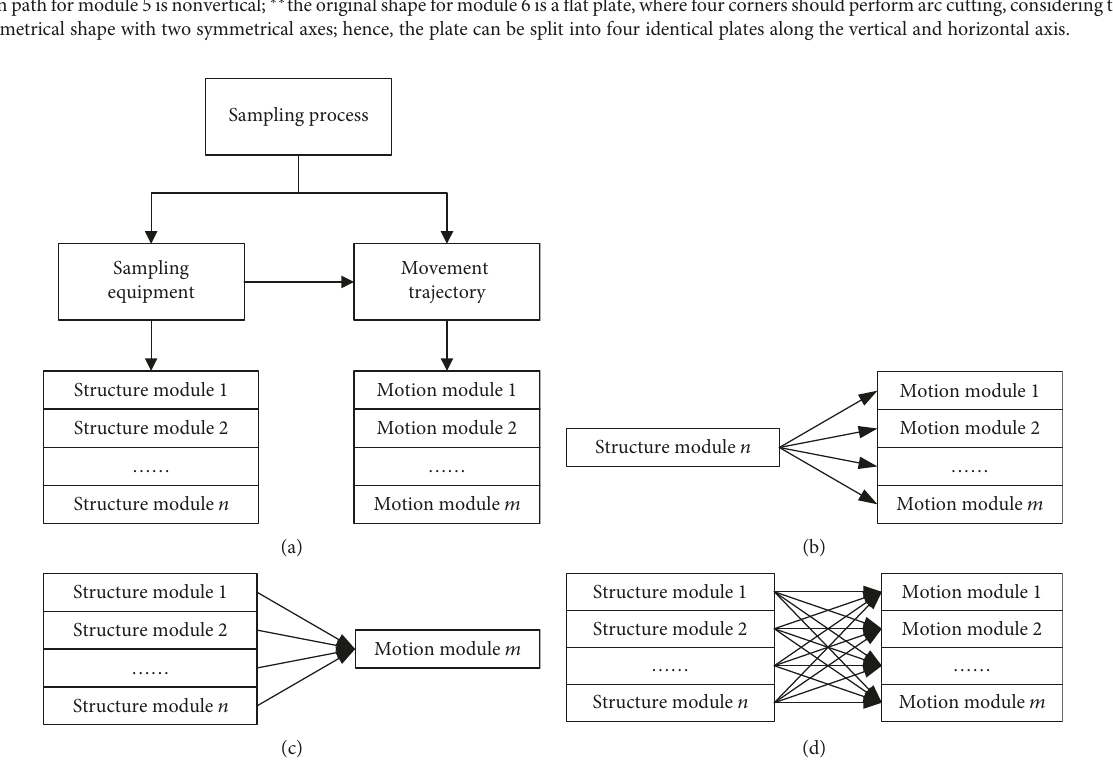
surface, and left and right surfaces, represented as F u 2 h , F , F F d 2 h l 2 h , and r 2 h respectively. The reaction dicular to the front surface of structure module T 1